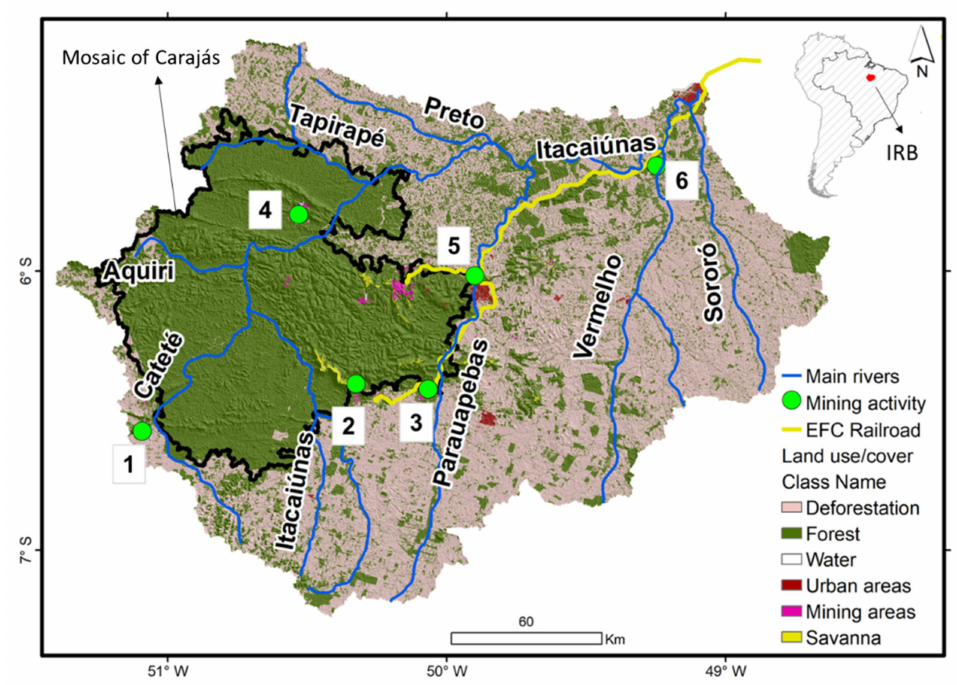
Figure 1. Itacai ú nas River basin location; the Mosaic of Caraj á s location; land-use classes; mining sites (Table 1) and main rivers. Table 1. Description of the strategic points indicated in Figure 1. ID